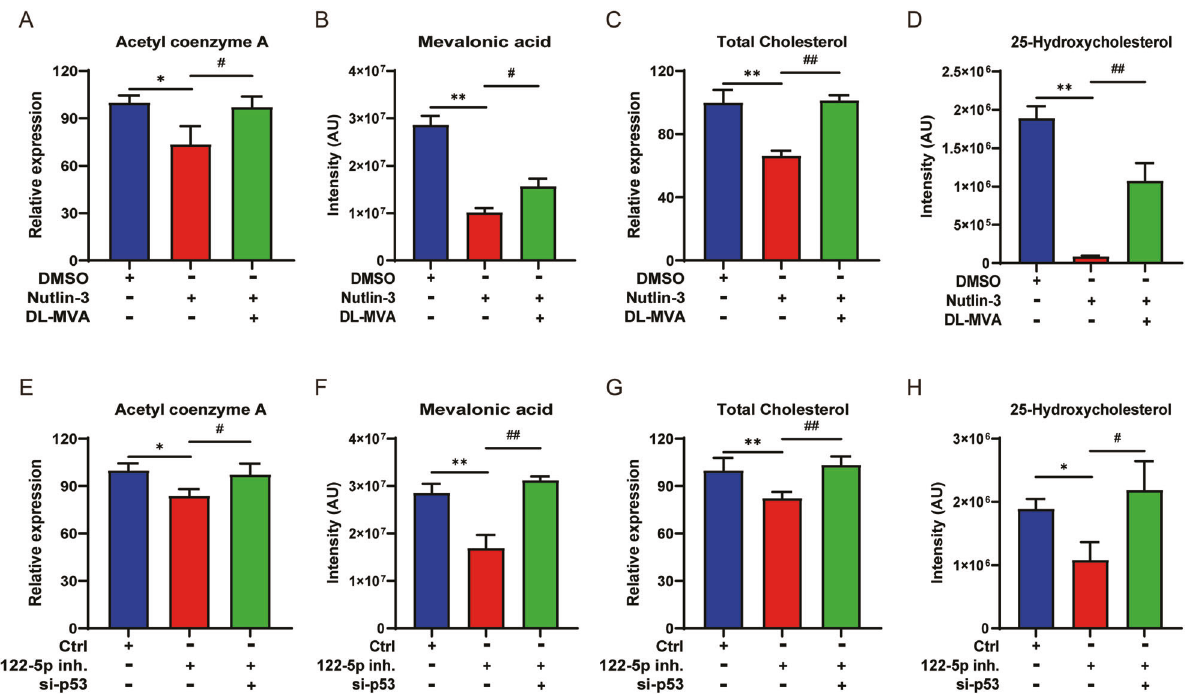
Fig. 4 Effect of miR-122-5p on the production of the MVA pathway metabolites through p53. A The changes of A-CoA in A549 cells treated with Nutlin-3 combined with DL-MVA or Nutlin-3 alone by ELISA kit. Nutlin-3 combined with DL-MVA or Nutlin-3 alone changes mevalonic acid ( B ) and 25-Hydroxyergosterol ( D ) by LC-MS in treated A549 cells. C The changes of TC in A549 cells treated with Nutlin-3 combined with DL-MVA or Nutlin-3 alone by biochemical kit. ( E ) The changes of A-CoA in A549 cells treated with 122-5p inh. combined si-p53 or 122-5p inh. alone using an ELISA kit. The changes of mevalonic acid ( F ) and 25-hydroxyergosterol ( H ) in A549 cells. G The changes of TC in A549 cells treated with 122-5p inh. combined with si-p53 or 122-5p inh alone by biochemical kit. The ctrl group was A549 cells treated with a medium solution containing 122-5p inh. NC and si-p53 NC. The above bar graphs were the sum of three independent experiments (mean ± SD), ns: not signi fi cant, * P < 0.05 and ** P < 0.01 vs DMSO or Ctrl group, # P < 0.05 and ## P < 0.01 vs Nutlin-3 or 122-5p inh.